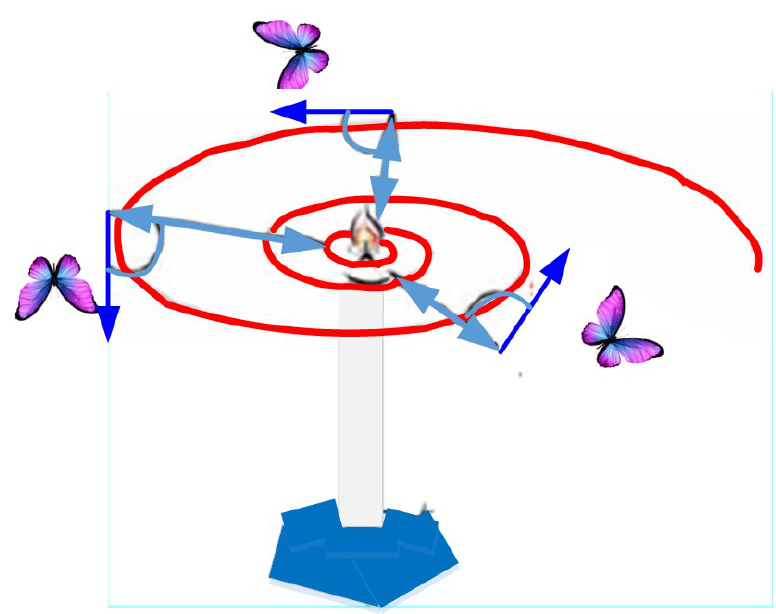
Figure 11. A moth's spiral flight route around a source of light. To develop the moth flame optimisation (MFO) algorithm, mathematical models of moth flight behaviour were used. MFO is a metaheuristic algorithm that defines parameters firstly, creates moths at random, determines each moth’s position, and tags the optimal response in relation to the light source (flame). To achieve better locations in relation to the light source, the moths’ future positions are modified based on the spiral path function. The requirements are satisfied (after obtaining the best solution) when this process, which involves updating the next positions and tagging the best solutions with respect to the flame, is completed [43]. Three main steps make up MFO: the creation of the initial moth population, the updating of the moth positions, and the updating of the flame count. Creating the initial population of moths in the first stage assumes that each moth can move in multiple dimensions. The moths’ set (M) matrix is as follows: